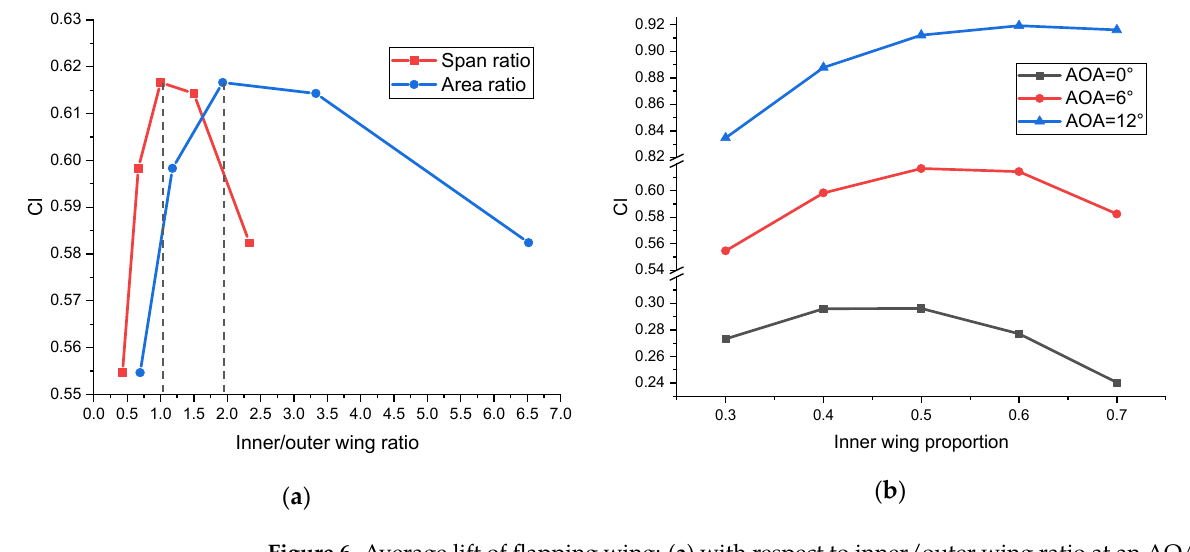
Figure 6. Average lift of flapping wing: ( a ) with respect to inner/outer wing ratio at an AOA = 6°; ( b ) with respect to inner wingspan proportion in different AOA.